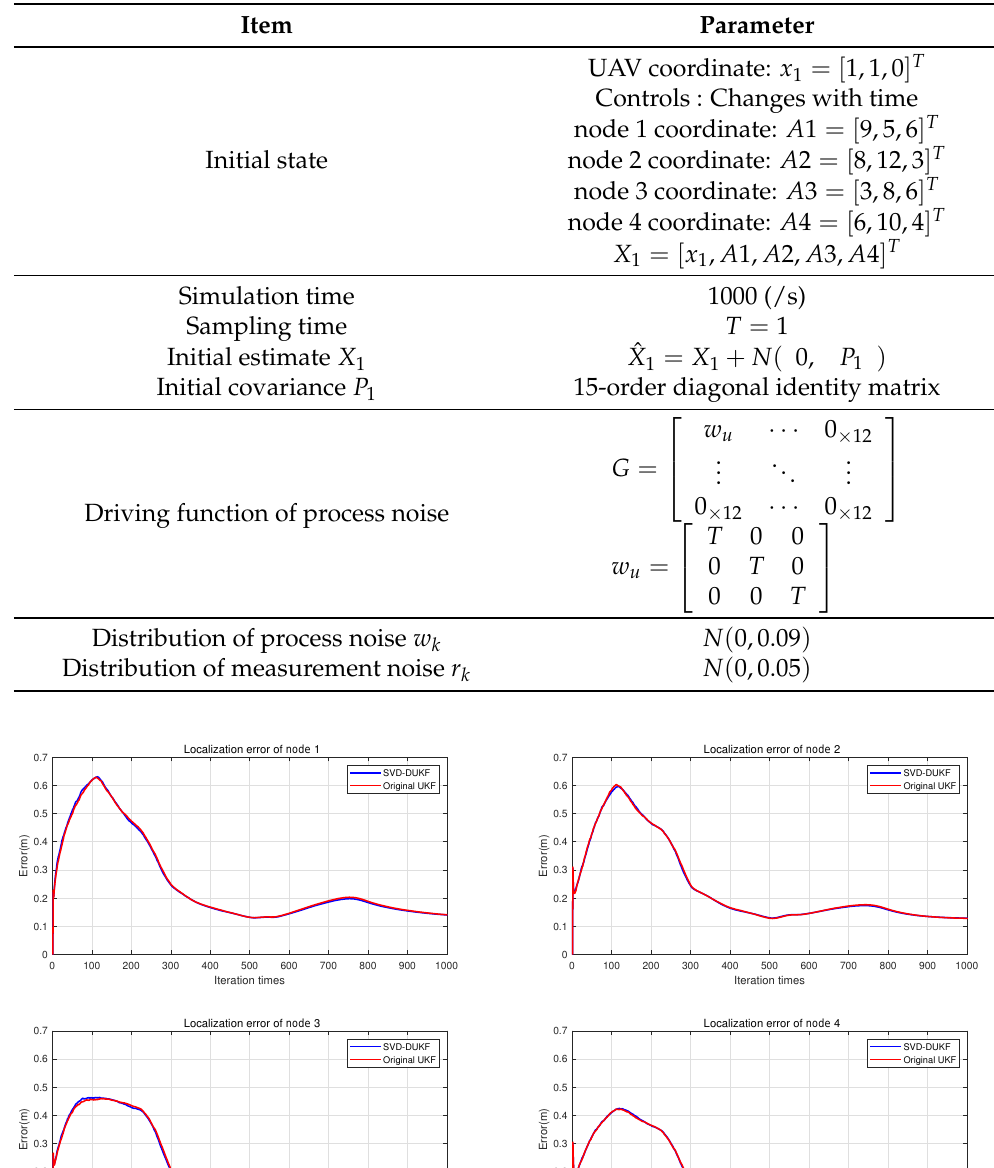
Table 3. Parameters used in the simulation.